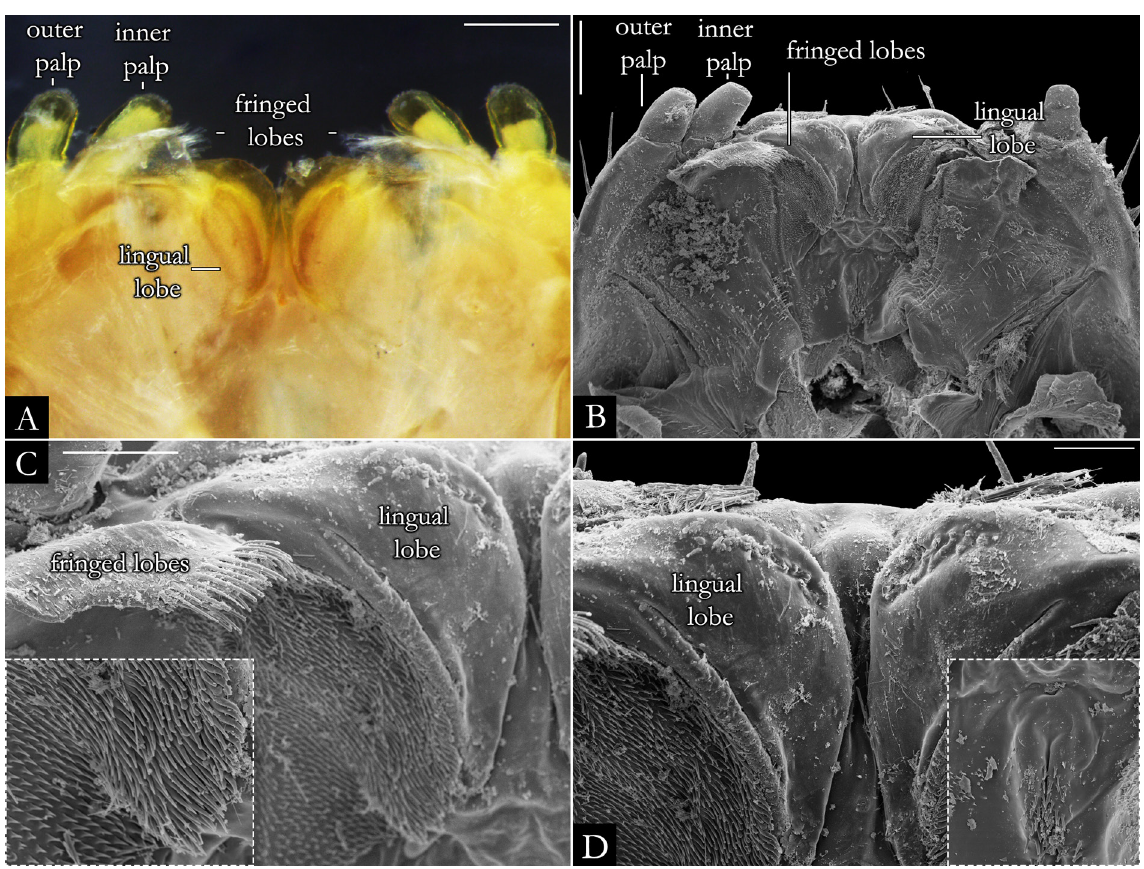
Fig. 24. SEM and stereoscopic images of hypopharynx Pseudonannolene robsoni Iniesta & Ferreira, 2014. A . Ventral view (IBSP 3526). B–D . Ventral view (IBSP 3504). Scale bars: A = 1 mm; B = 0.2 mm; C–D = 0.1